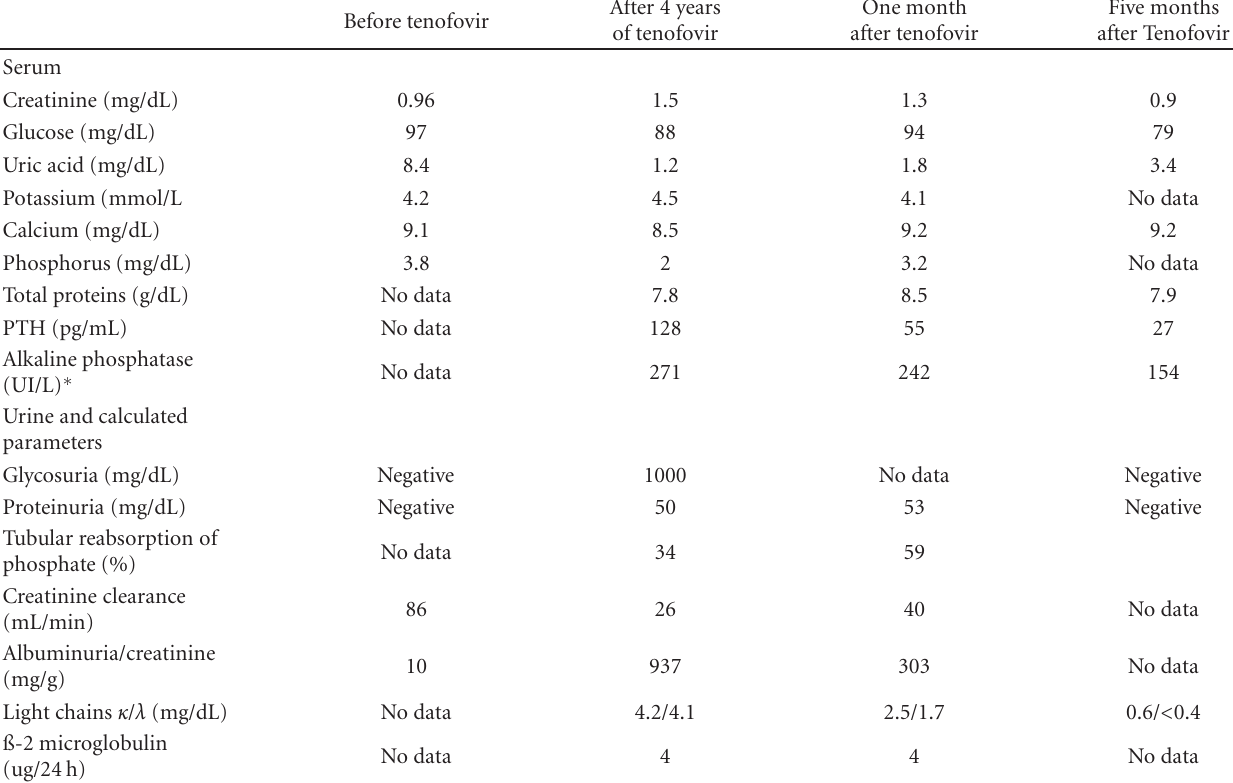
Table 2: Biochemical features and time course of a case of tenofovir-associated Fanconi syndrome.